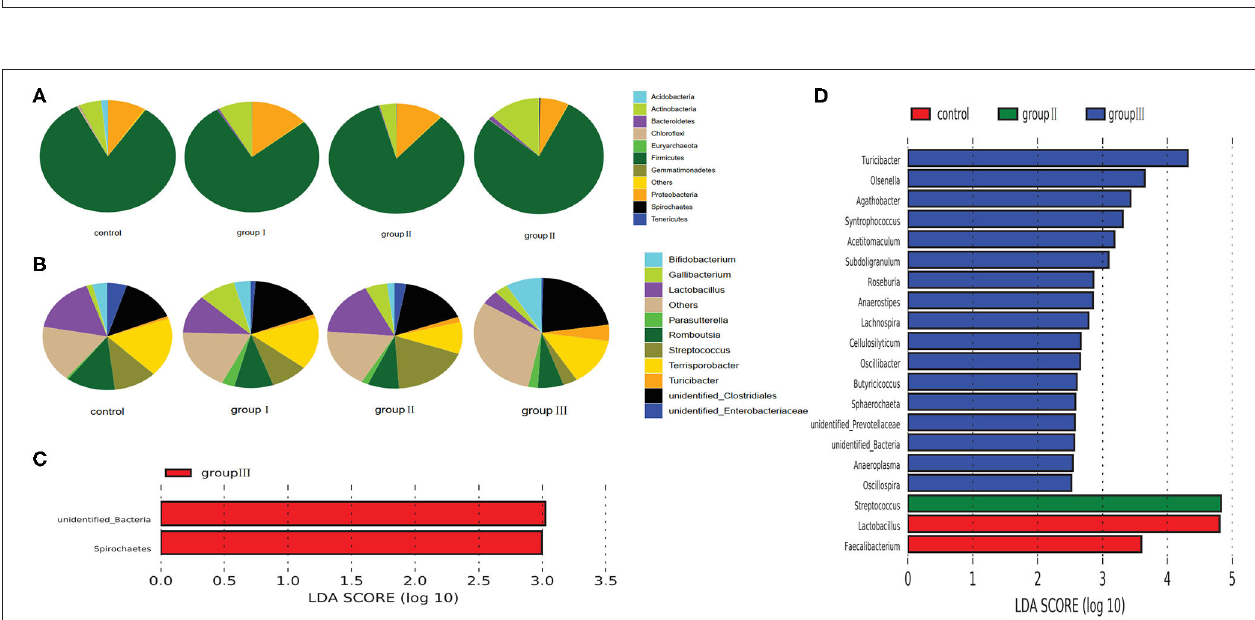
FIGURE 5 | Composition analysis of bacteria in the jejunum from four dietary groups. Microbial composition at the phylum (A) and genus (B) level. LEfSe identified significantly different bacteria according to the relative abundance among the four dietary groups at the phylum level (C) and genus level (D) ( p < 0.05, LDA Score > ± 2.0 at the phylum level, and LDA Score > ± 2.5 at the genus level).